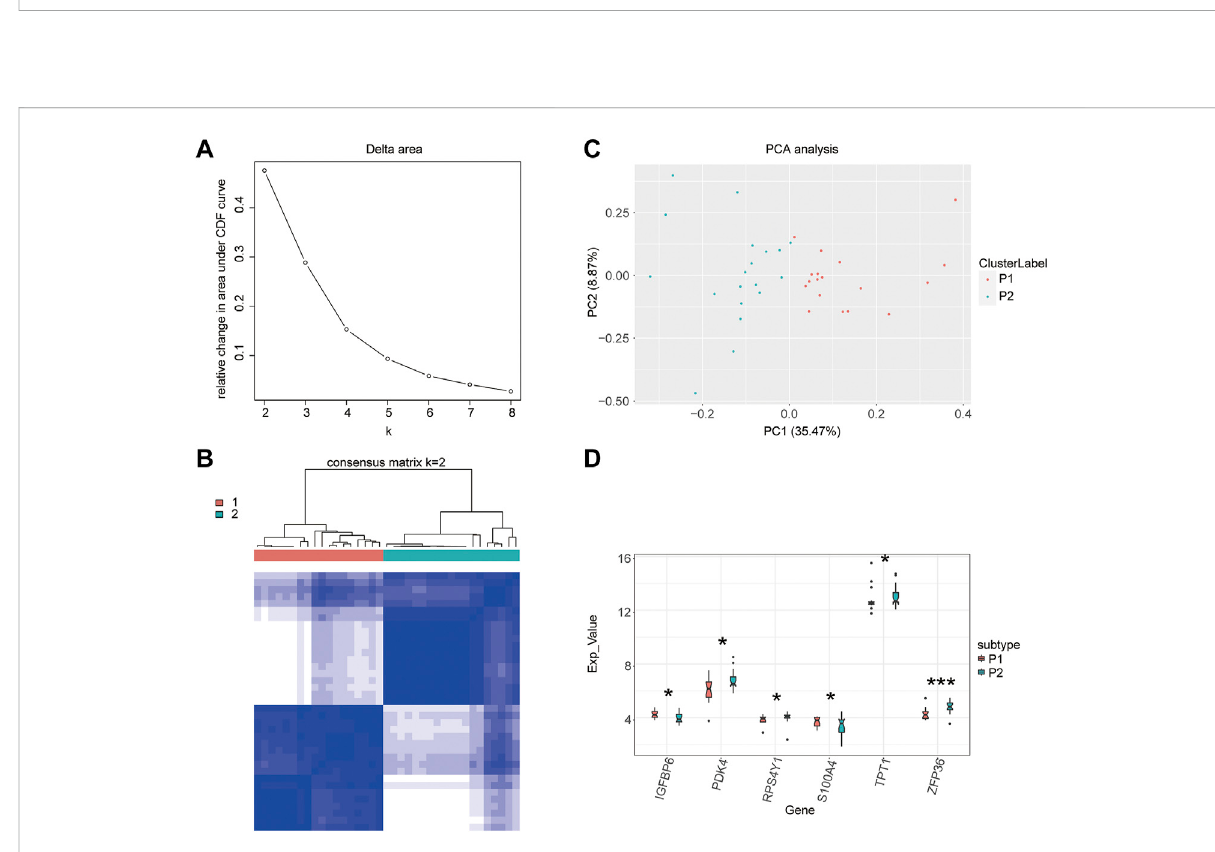
FIGURE 4 Unsupervised clustering of samples. (A) Selection of the optimal clustering number. (B) Clustering heatmap. (C) Principal component analysis. (D) Boxplot of the